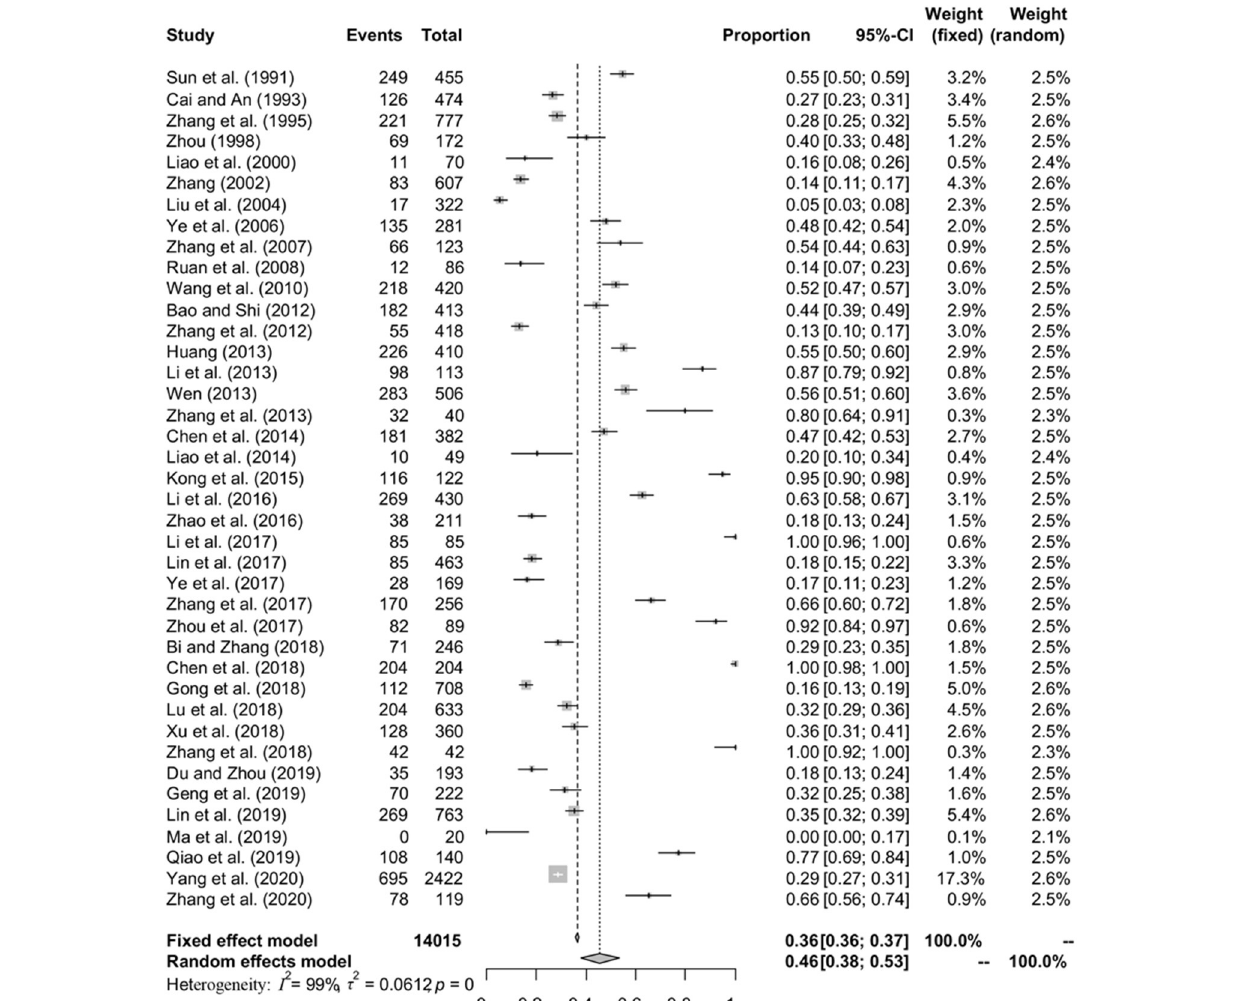
( < 70% vs. other humidity categories), mean temperature